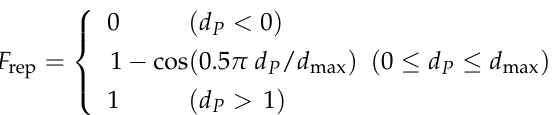
where 𝜆 is the ratio of the slice where point 𝑃 is located to the height of the cone, 𝑑 (cid:3017) is